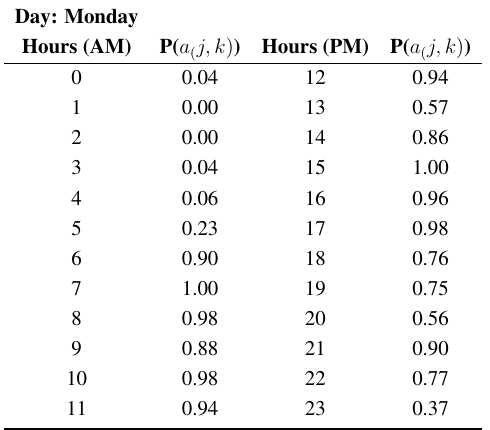
Table 4. Probability of events on the example of the weekday,